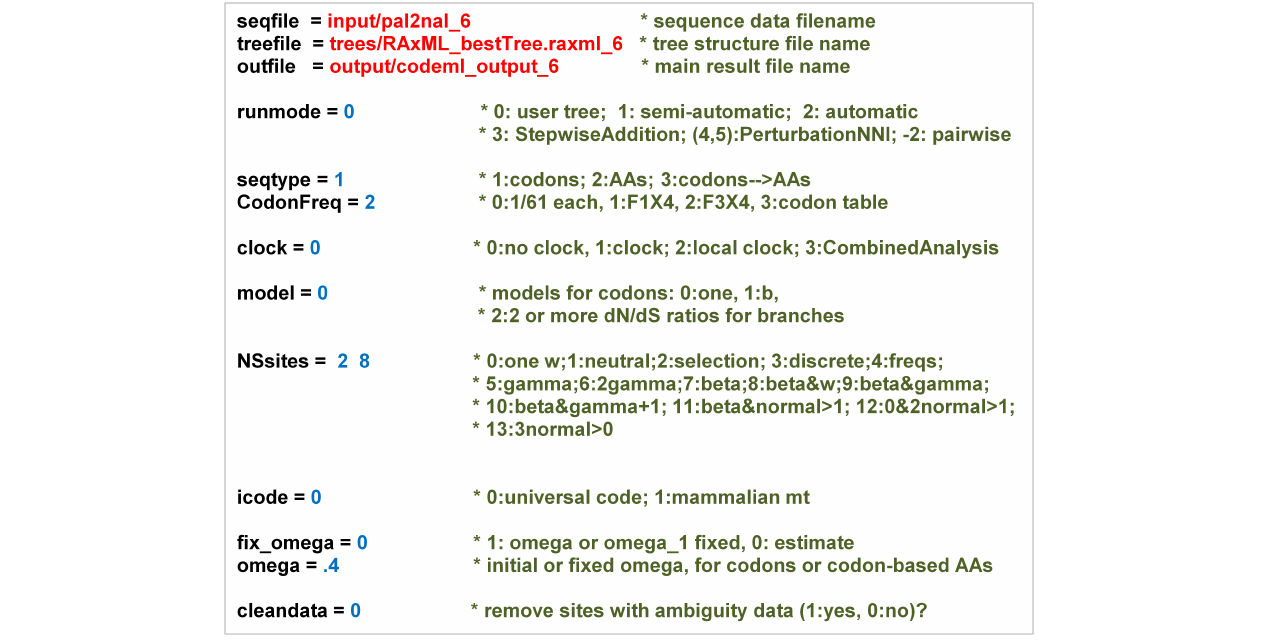
FIGURE 2 | CODEML configuration file settings used to estimate the amino acid sites under positive selection. This figure shows the values set within the CODEML configuration file to detect positive selection sites in target pathogen proteins. CODEML is a program within the Phylogenetic Analysis by Maximum Likelihood (PAML) package that estimates non-synonymous and synonymous evolutionary rates. Configuration values set by a user follow the ‘=’. The same settings were used for each processed ortholog group – except seqfile, treefile, and outfile were changed to uniquely match a specific group. Text preceding with a ‘ ∗ ’ is a comment, which specifies the range of possible options. These options are explained in detail in the PAML Manual (http://abacus.gene.ucl.ac.uk/software/paml.html).